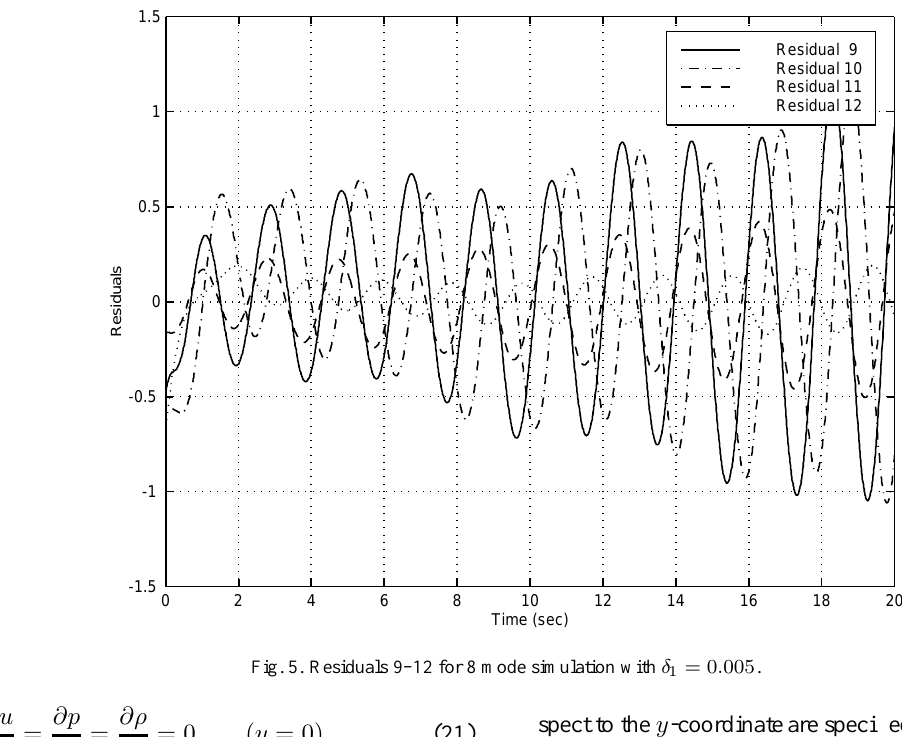
Fig. 5. Residuals 9–12 for 8 mode simulation with δ 1 = 0 . 005